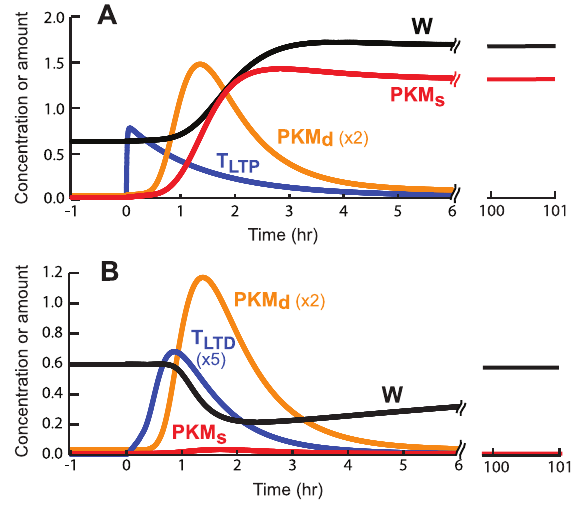
Figure 7. Simulation of cross capture. Vertical scaling factors are indicated next to the appropriate variable. D t for each simulation is 20 min. A , WTET is delivered to S1 before SLFS is delivered to S2. Illustrated synaptic variables are for S1. The break in the x axis, followed by the traces for PKM s and W between 100 and 101 h, illustrates the permanent transition of PKM s and W. B , WLFS is delivered to S1 followed by a STET to S2. LTD results, but begins to decay after several h, as N and therefore W increase towards baseline with the slow time constant t N .